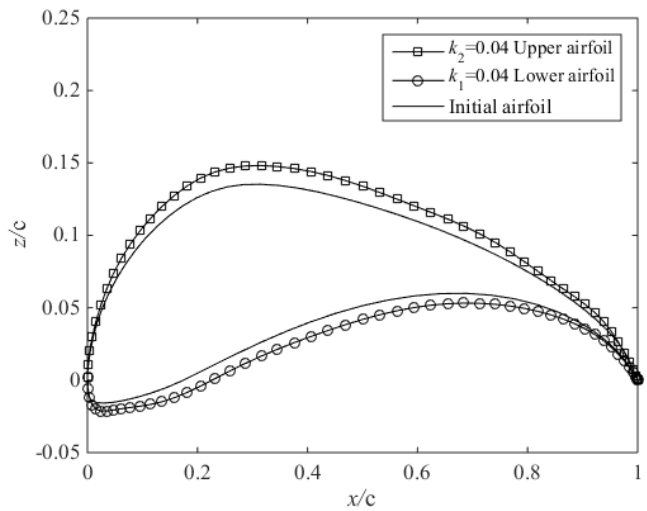
Figure 15. Range of the S1223 airfoil at k 2upper = 0.04 and k 1lower = 0.04.